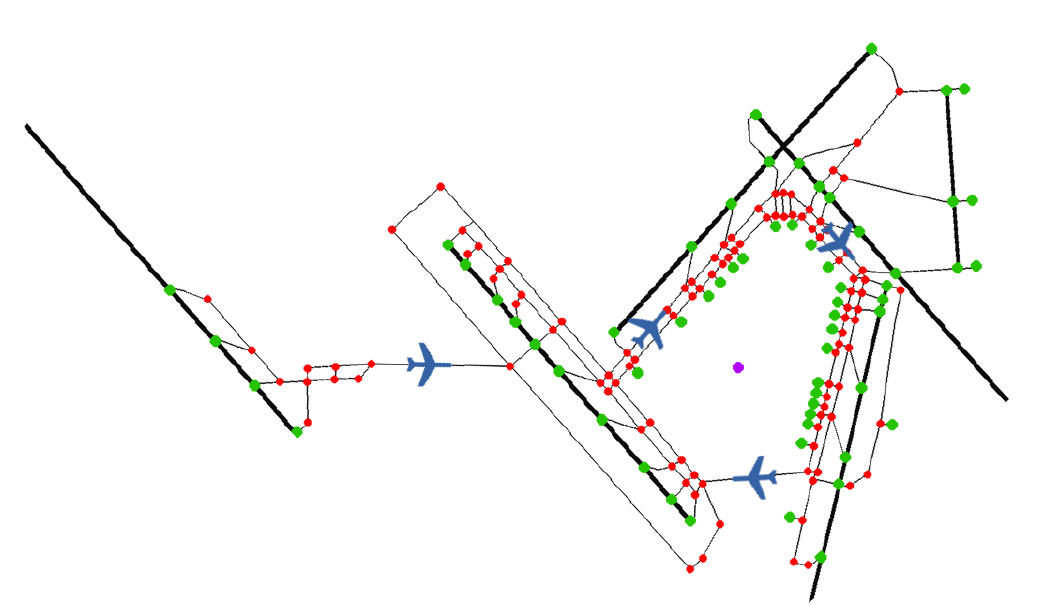
Figure 3. The graph representation of the taxiways and runways of Schiphol Airport. The red dots represent the ATC Agents. The green dots are the locations of the Entry/Exit Agents. The blue airplanes are the Aircraft Agents, and the purple dot is the Airport Operation Status